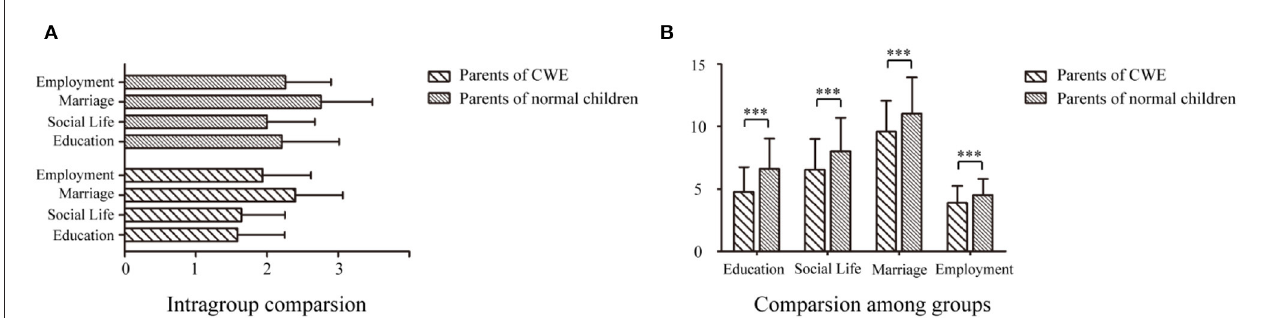
FIGURE 2 | Attitude toward the four social aspects of life in people with epilepsy among parents of children and adolescents with epilepsy and the control group. (A) Intragroup comparison: Mean scores per item of attitudes toward the four social aspects of life in people with epilepsy among parents of children and adolescents with epilepsy and the control group, respectively. (B) Comparison among groups: Attitudes toward four social aspects of life in people with epilepsy parents of children and adolescents with epilepsy and the control group. Statistical significance ( p < 0.001) is marked with ***.